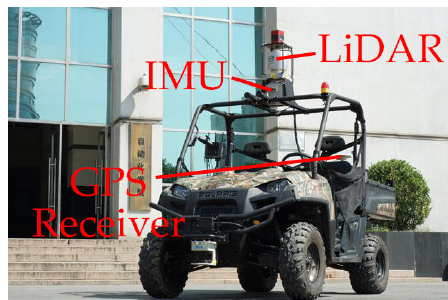
Figure 17. The vehicle used in experiments on rough terrain.